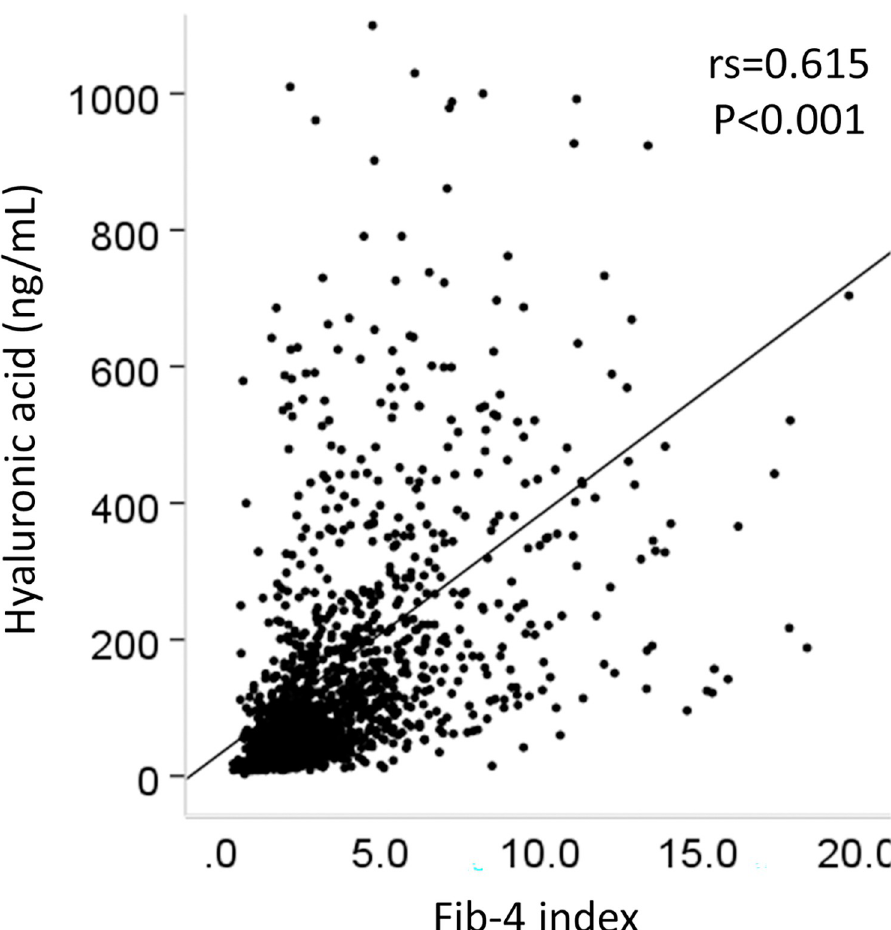
Fig 8. Correlation between HA and the Fib-4 index. rs, correlation